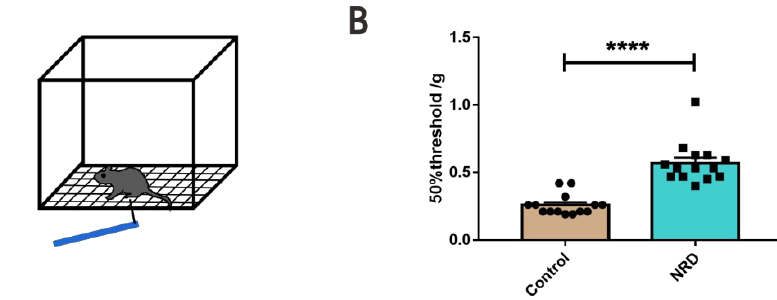
Figure 10. Declined pain sensitivity in NRD mice. ( A ) Schematic of von Frey filaments test. ( B ) Quantitative allodynia assessment by fifty percent paw withdrawal threshold testing. **** p < 0.0001 as determined by unpaired Student’s t -test. Data are expressed as the means ± SEMs. n (control) = 14, n (NRD) = 14.